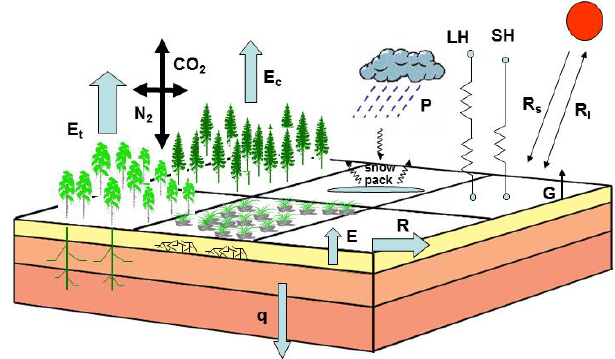
Figure 3. Schematic of “third-generation” LSMs, which are simi- lar to generation 2A (Fig. 1) except that now the carbon budget is coupled to the calculation of the water and energy budgets through parameterizations of stomatal behaviour. However, these models do not incorporate the improved treatments of subgrid spatial variabil- ity and hydrological processes developed in generation 2B (Fig.